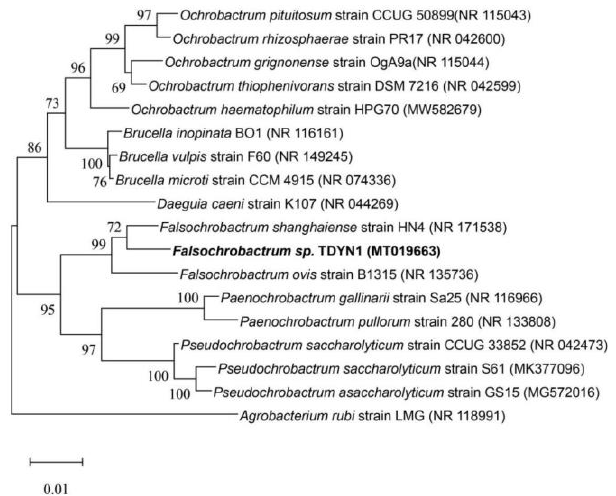
Figure 1. Phylogenetic trees of Falsochrobactrum sp. TDYN1. Phylogenetic trees were constructed based on the 16S rRNA gene sequences (1371 bp) using the neighbor-joining method. The phylogeny test used the bootstrap method with 1000 replications.